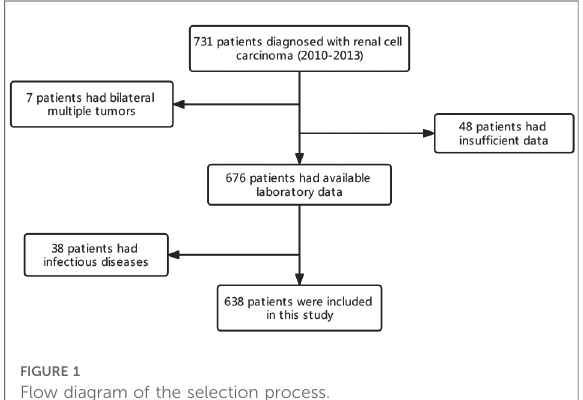
FIGURE 1 Flow diagram of the selection